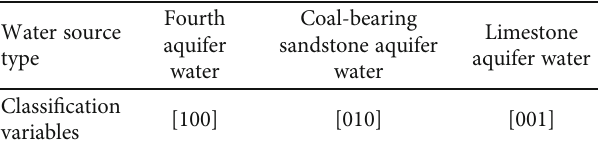
Figure 6: Loading scatter plot of PCA. 100: fourth aquifer water; 010: coal-bearing sandstone aquifer water; 001: limestone aquifer water. Table 2: Classi fi cation variables of di ff erent water source